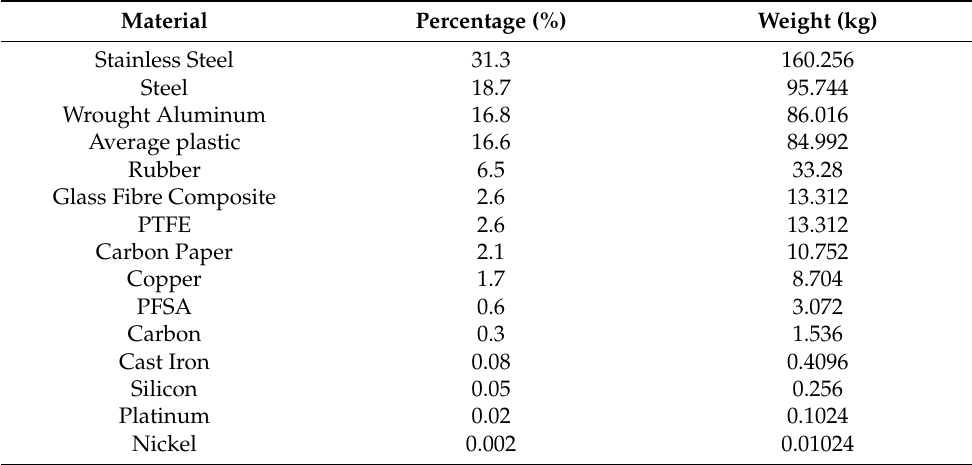
Table 2. Scaled BOM for FC stack.